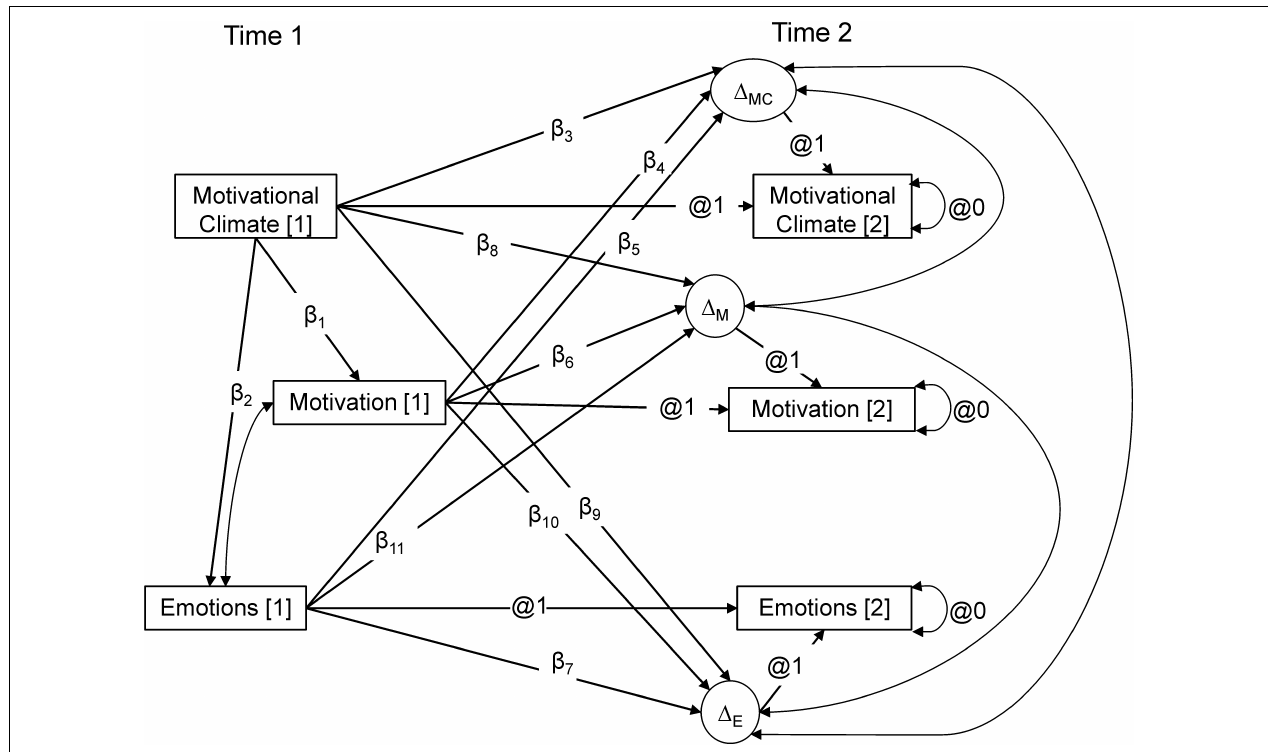
FIGURE 1 | Hypothesized latent change score model of motivational climate, motivation regulations, and emotions. (cid:49) represents latent change score.